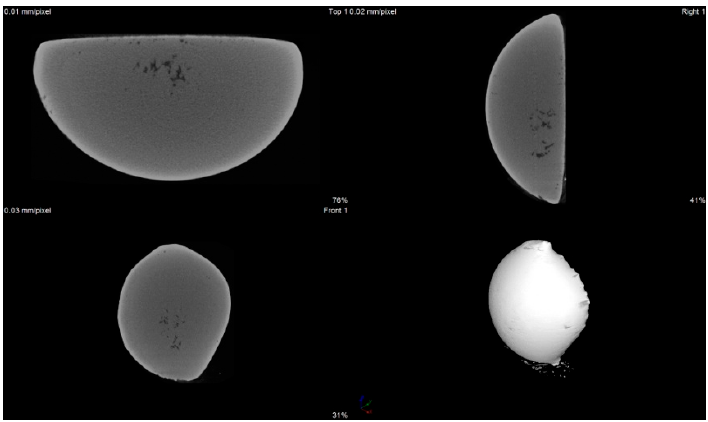
Figure 4. Typical distribution of temperature in molten titanium samples captured by IR camera during solar melting: ( a ) green diameter of 15.1 mm and height of 3.0 mm; ( b ) green diameter of 29.2 mm and height of 5.2 mm. The non ‐ calibrated temperature scale is in the middle . Figure 5. X ‐ ray micro tomography of small droplet after solar melting: cuts in X, Y, Z planes and 3D picture of droplet. Final porosity 2.4%.